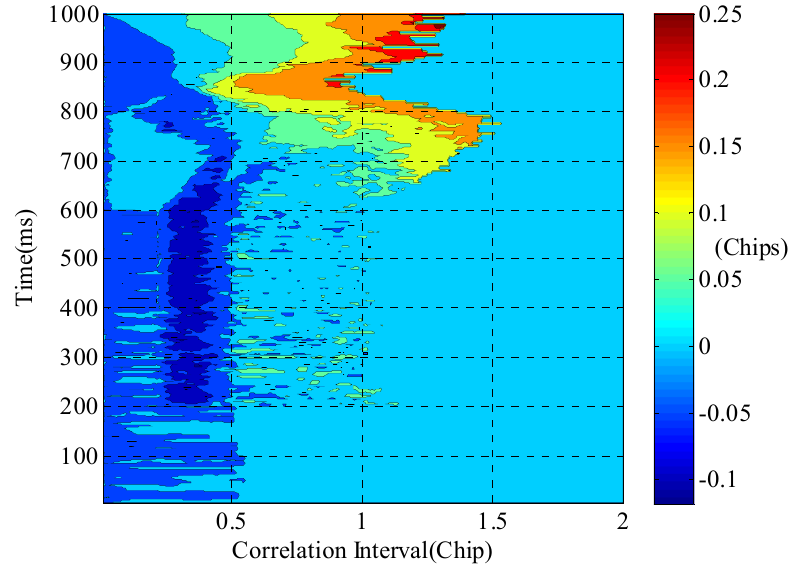
Correlation Interval(Chip) Figure 15. SCB waterfall diagram in the interference scenario. Figure 15. SCB waterfall diagram in the interference scenario. Using the traditional detection method of the number of correlation peaks and the SCB curve threshold method, the thresholds are set to 0.12/0.14/0.16/0.18, respectively, to detect the spoofing interference; the detection results are shown in Figure